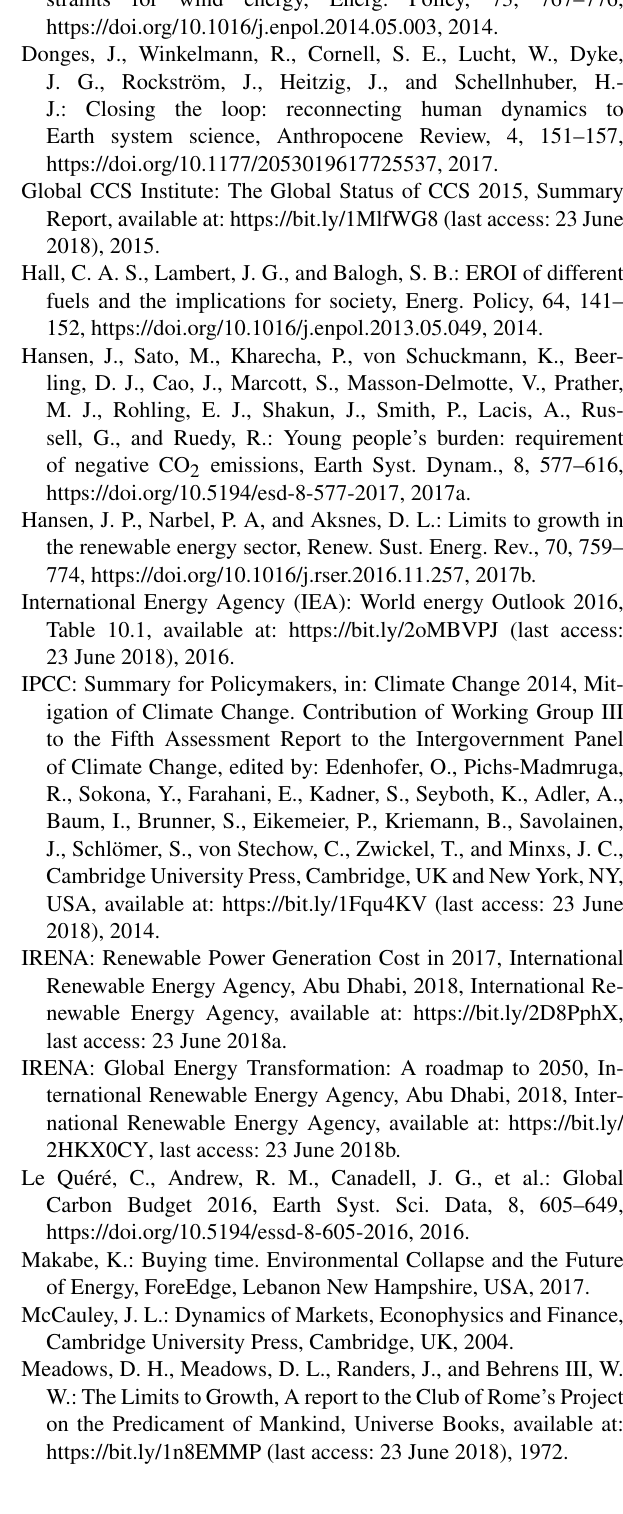
Table 10.1, available at: https://bit.ly/2oMBVPJ (last